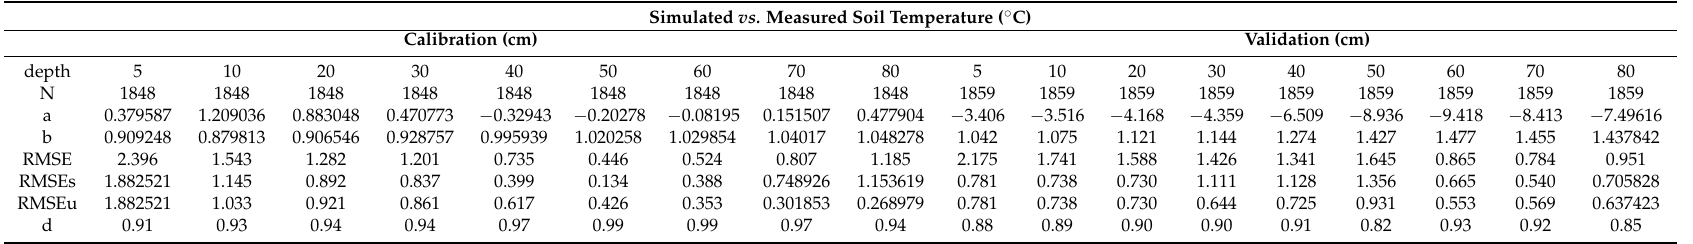
Table 5. Statistical measures of HYDRUS-1D model performance for simulations of soil temperature at different soil